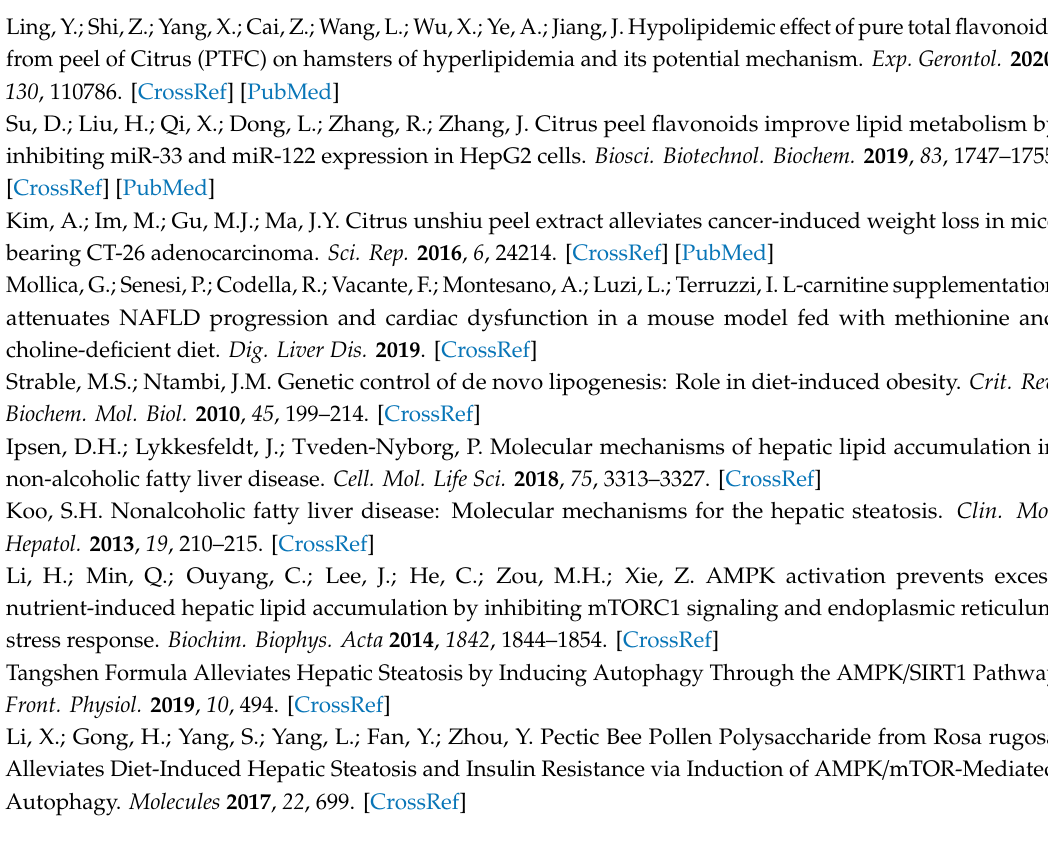
Figure S1: The e ff ects of Citrus peel extract on body weight and food intake in high fat diet-induced hepatic steatosis in rat. Table S1: Sequences for Primers Used in Real-time